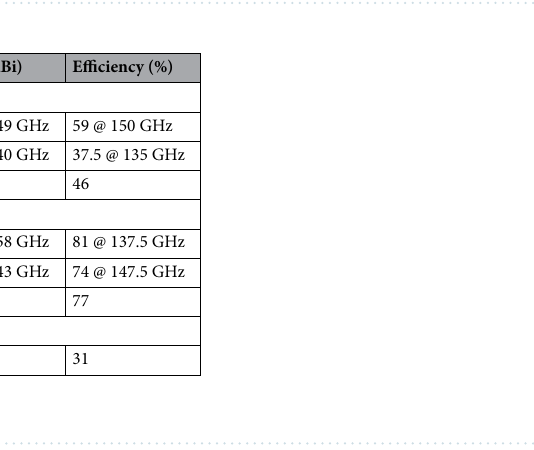
Figure 4. ( a ) Simulated gain of the OCA under two conditions, (1) MTM-IMC and without (WO) slot, and (2) MTM-IMC and with (W) slots, ( b ) simulated and measured gain of the OCA before and after applying MTM- IMC and slots, and ( c ) simulated and measured efficiency of the OCA before and after applying MTM-IMC and slots radiation efficiency.